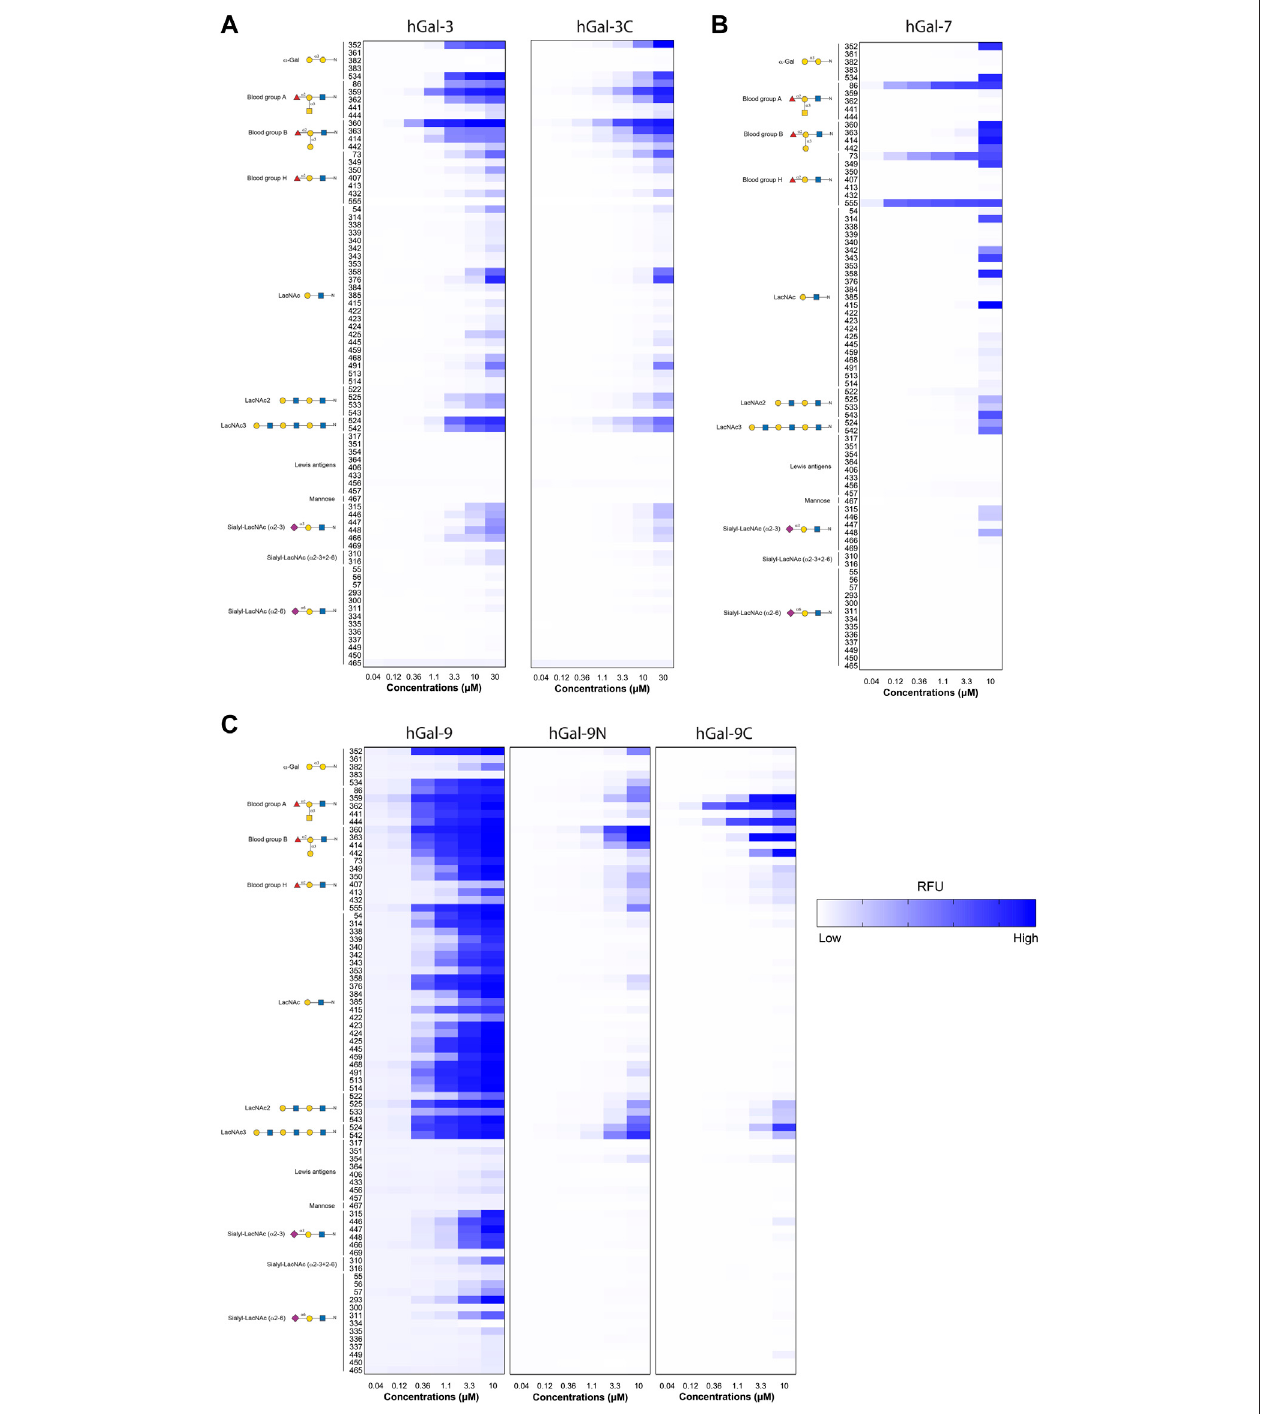
FIGURE 1 | Examination of GBP-glycan binding af fi nity over multiple concentrations. (A) Heatmaps for the RFU values of Gal-3 and Gal-3C over a broad range of concentrations starting from 0.04 to 30 μ M for antigens on N-Glycans. (B) Heatmap for the RFU values of Gal-7 over a range of concentrations starting from 0.04 to 10 μ MforantigensonN-Glycans (C) HeatmapsfortheRFUvaluesofGal-9,Gal-9N,andGal-9Coverarangeofconcentrationsstartingfrom0.04to30 μ Mforantigens on N-Glycans. Detailed Symbol Nomenclature for Glycans (SNFG) structures and examples of glycans examined are shown on the left. The higher RFU value is shown with darker blue and lower RFU value shown in lighter